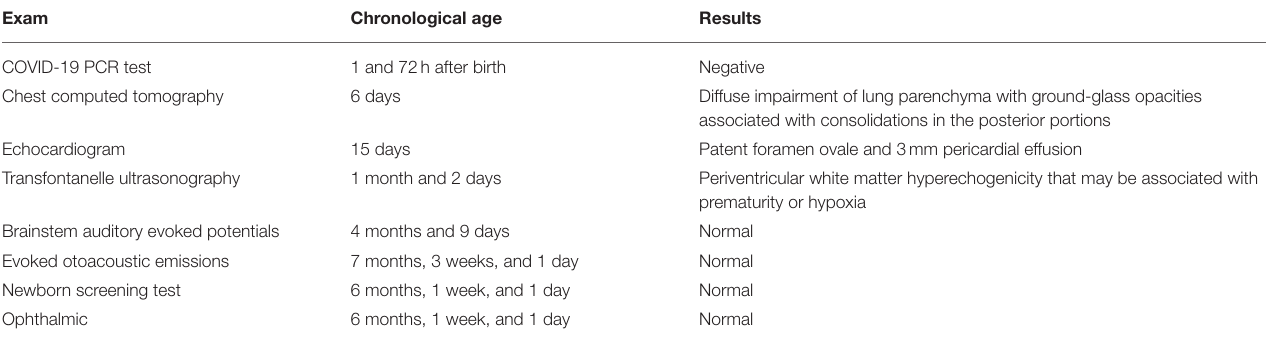
TABLE 1 | Exams performed to assess body functions and